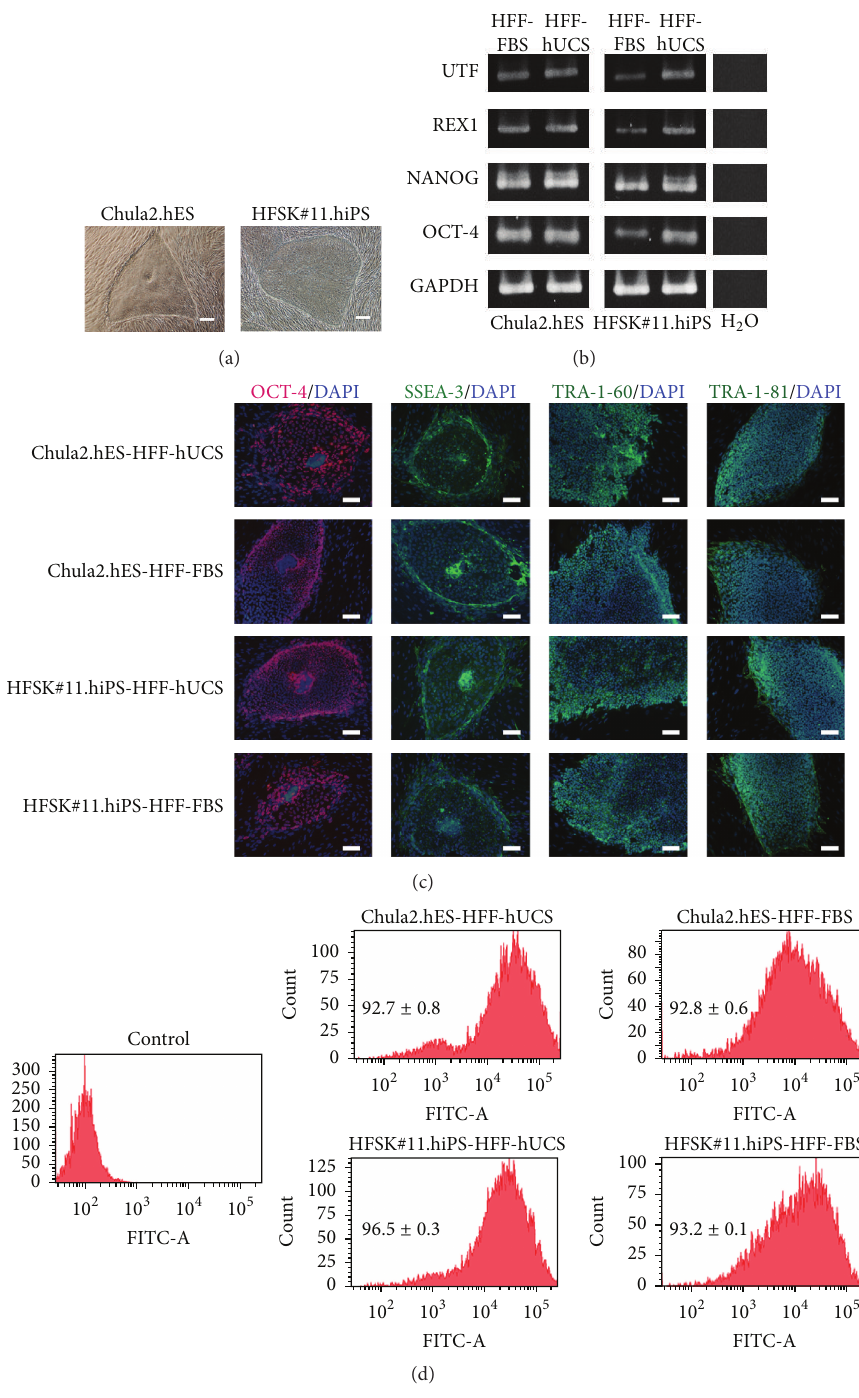
Figure 4: Characterization of human pluripotent stem cells after coculture with HFF-hUCS feeder cells. Two karyotypic normal hPSC lines, hESC (Chula2.hES) and hiPSC (HFSK#11.hiPS), were cocultured with inactivated HFF-hUCS or inactivated HFF-FBS, and